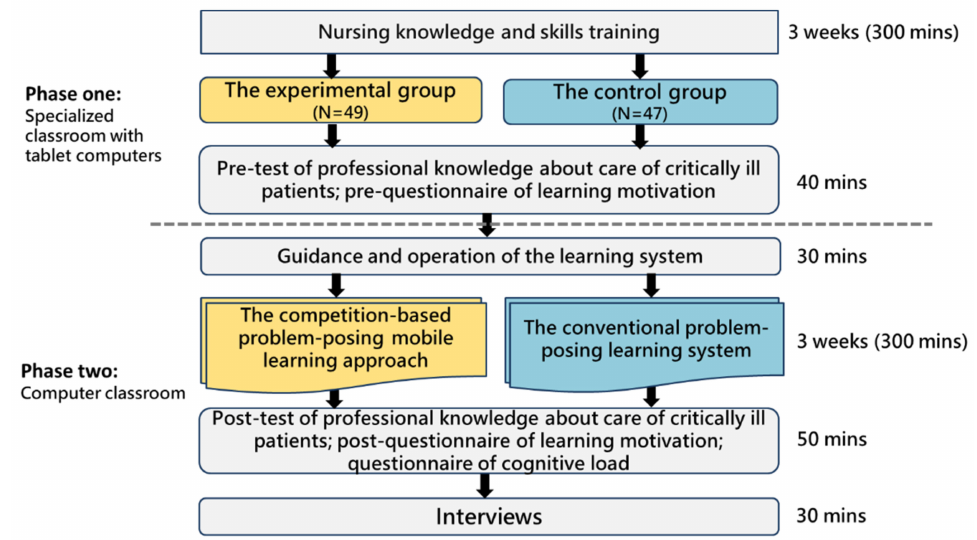
Figure 5. Experimental